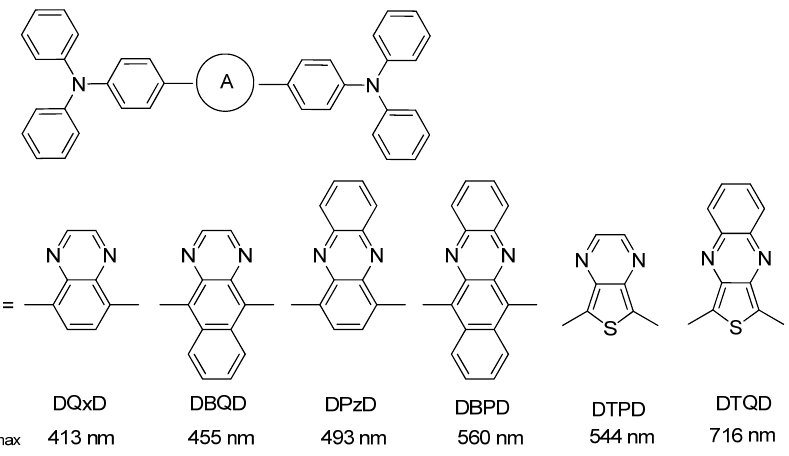
Figure 1. Structure of benzopyrazine- and thienopyrazine-based chromophores with triphenylamine donors.